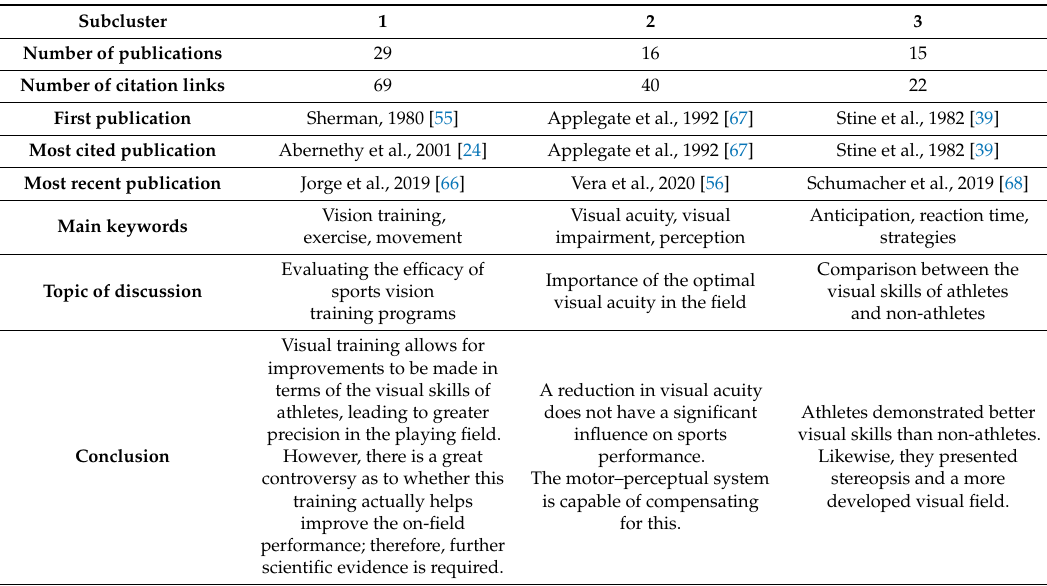
Figure 10. Citation network from the subclusters in group 2. Table 10. Main groups of citation network of subcluster in group 2.